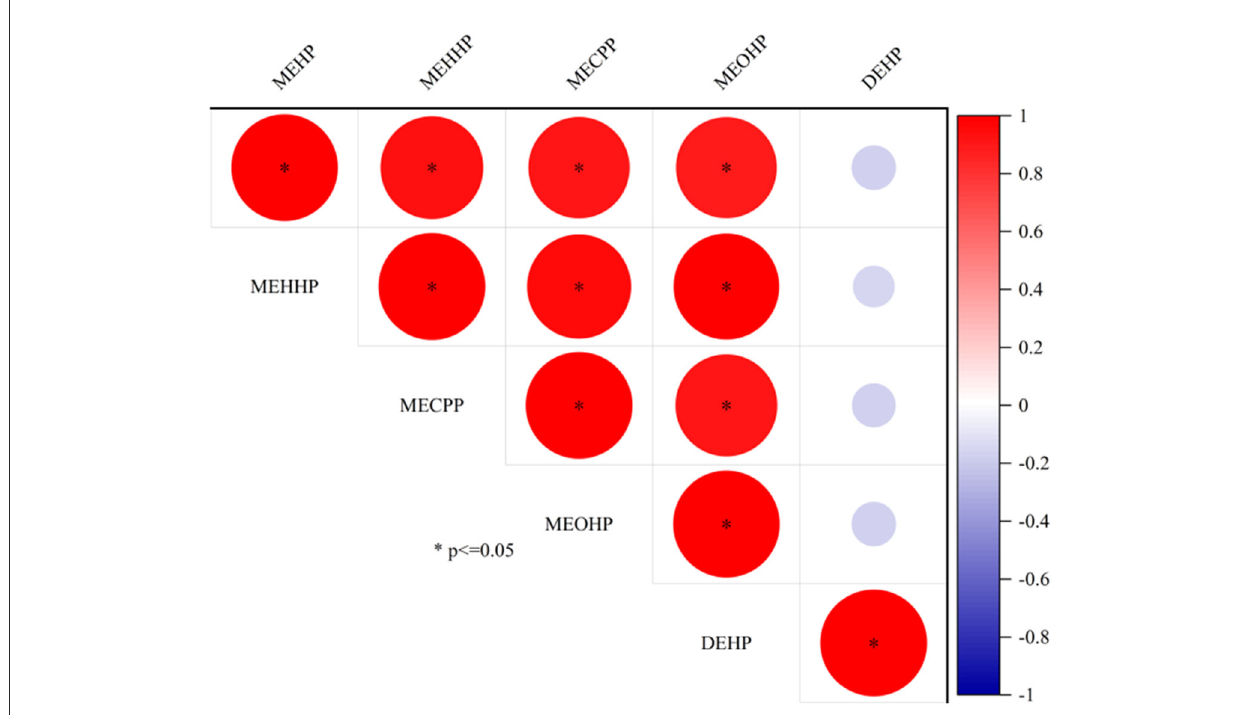
FIGURE2 The correlation between DEHP and DEHP metabolite concentrations in